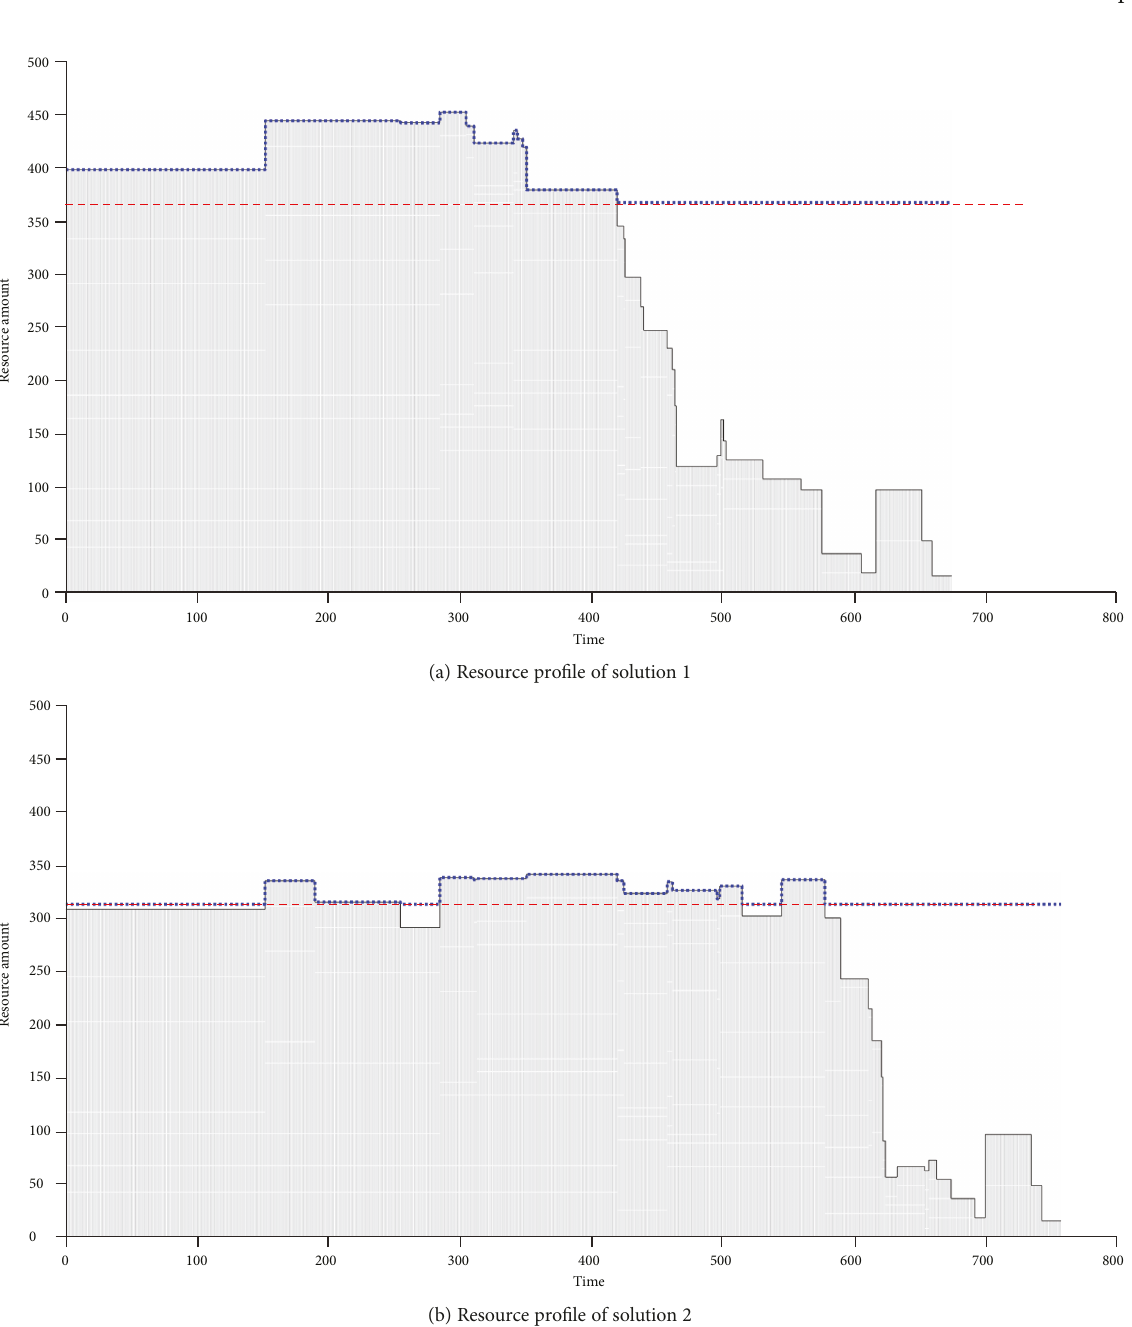
Figure 10: Resource pro fi le of solution 1 and solution 2.